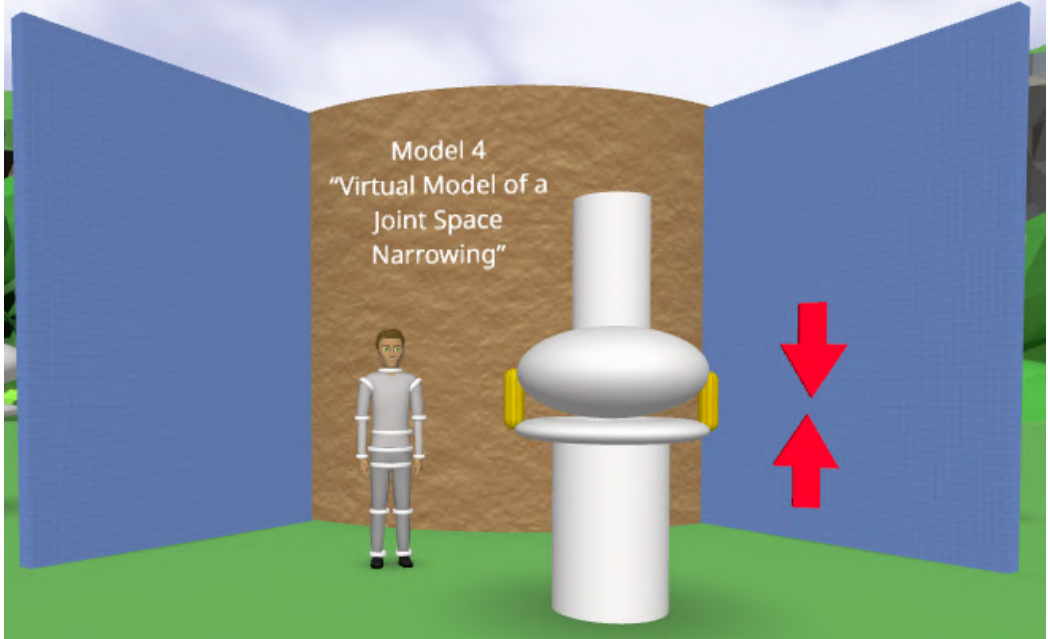
Figure 12: “Virtual Model of Identifying the Risks for Locomotor Apparatus Caused by Ligament Stretching”: Model 4 – “Virtual Model of a Joint Space Narrowing”